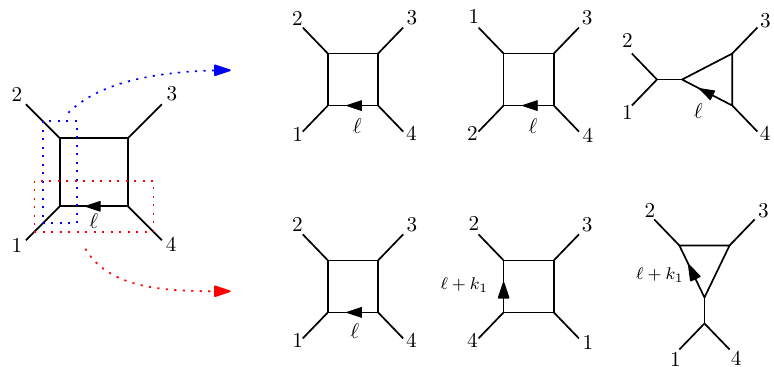
Figure 1 . Illustration of the labeling problem. At one-loop in string theory the loop momentum can be globally defined by the property that it always starts after the n -th leg, here leg 4 on the left-hand side box graph. Top: example of BCJ identity which does not change the definition of the loop momentum. Bottom: identity which changes the definition of the loop momentum. Note that the rightmost graph has a correctly defined loop momentum because leg 1 is to the left of leg 4